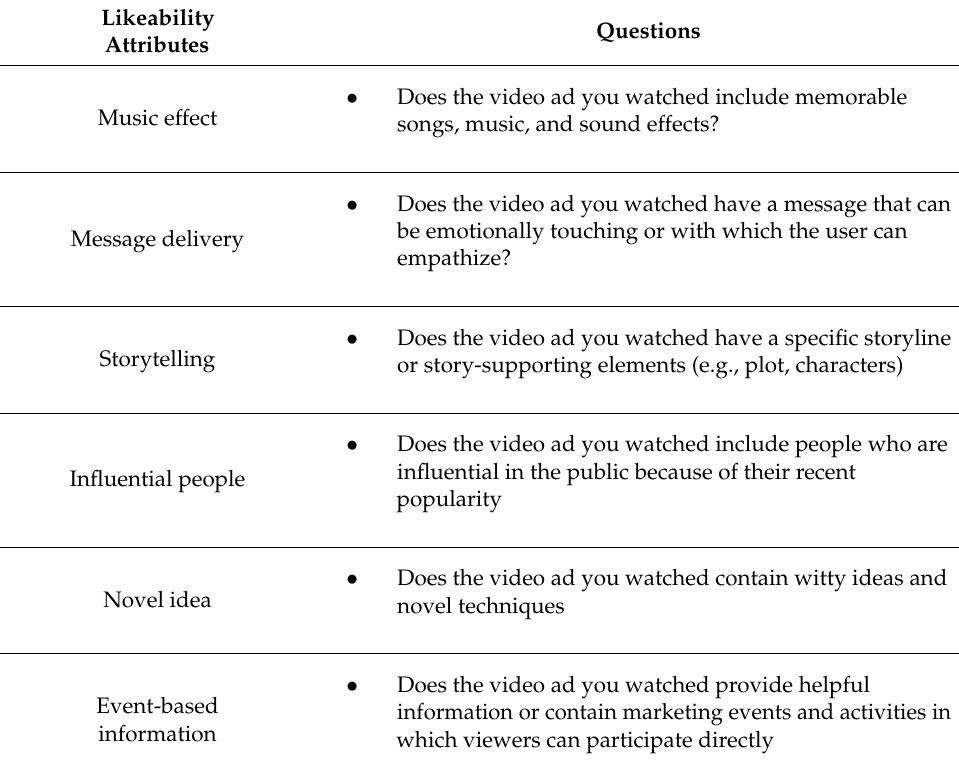
Table 2. Pre-survey questions.